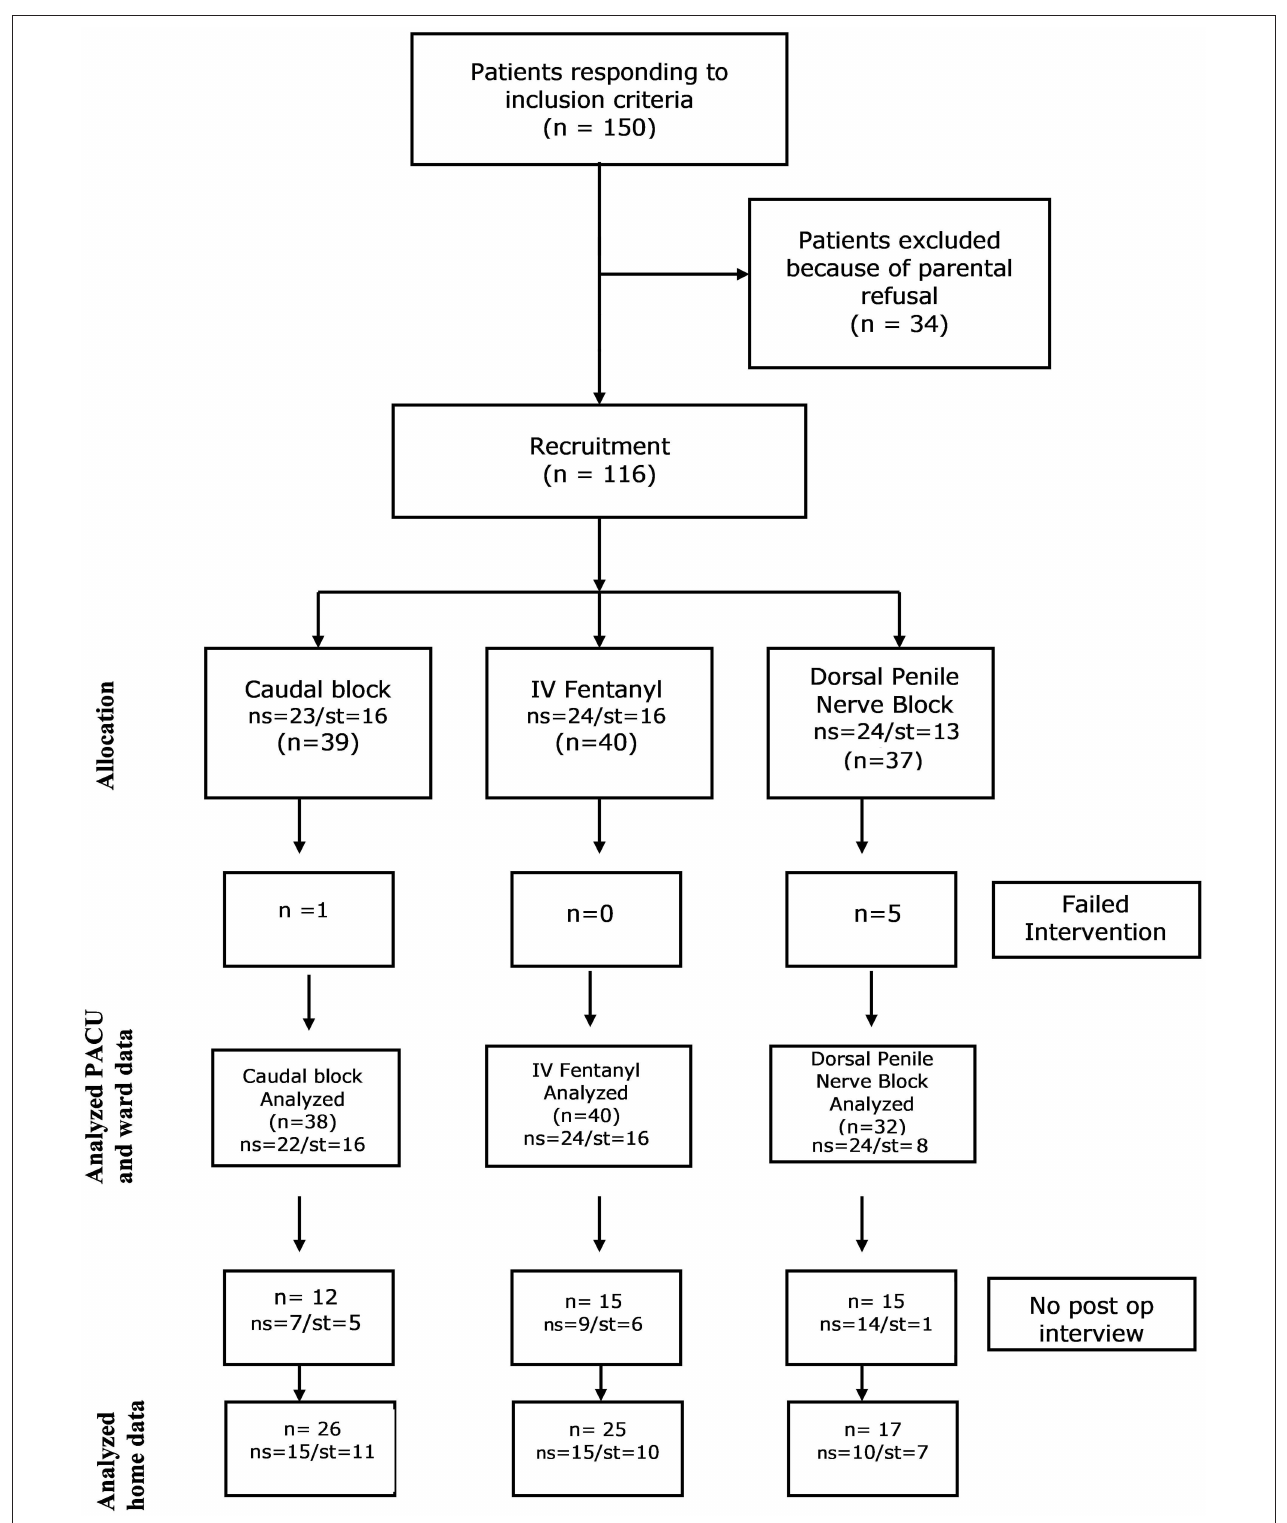
FIGURE 1 | Flow diagram of the study cohort. ns, no penile stent placed; st, penile stent placed; PACU, post anesthesia care unit.